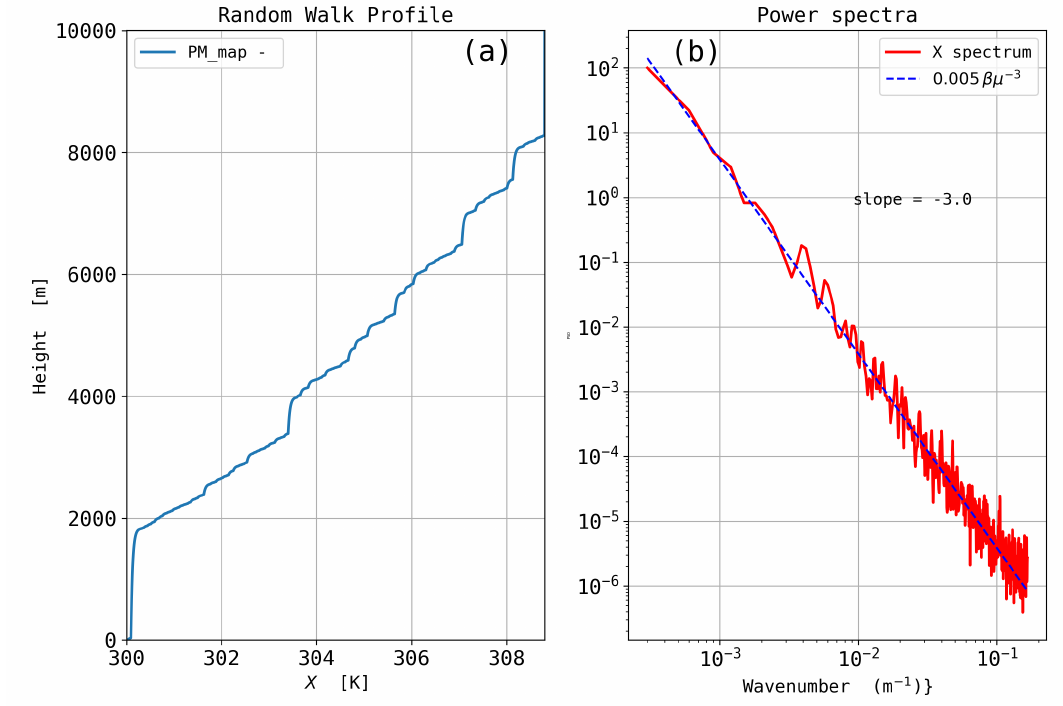
Figure A4. ( a ) simulation of a sorted PT profile based on Poisson clutters. ( b ) The corresponding power